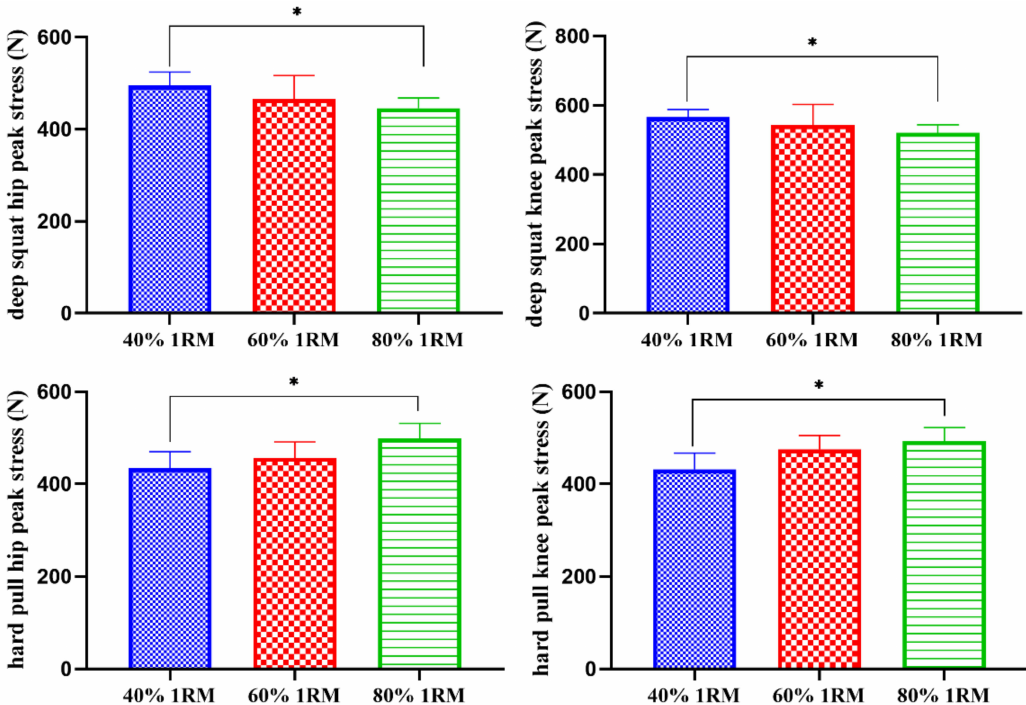
Figure 7. Comparisons of the different load intensity test peak stress (N). * There was a significant difference between 40% 1RM and 80% 1RM ( p < 0.05).